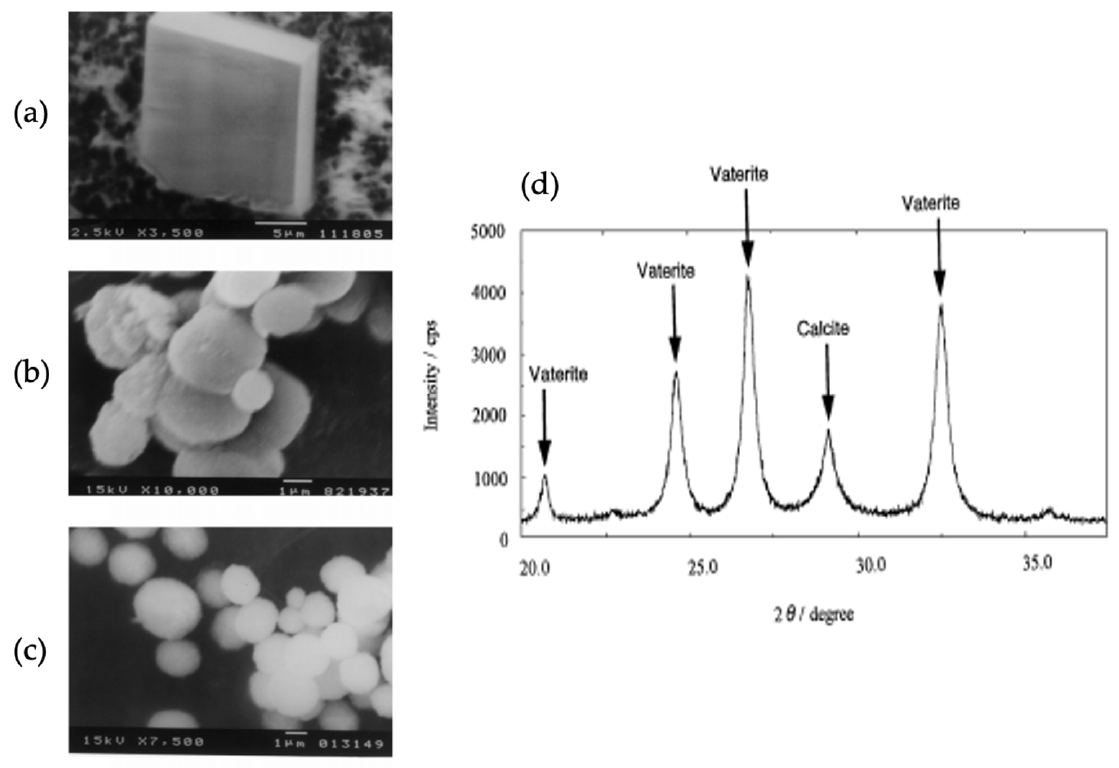
Figure 15. SEM micrographs of CaCO 3 crystals grown on a glass substrate; ( a ) in the absence of macromolecules; ( b ) in the presence of PGA; ( c ) in the presence of DNA. ( d ) X-ray diffraction pattern of CaCO 3 crystals. Soluble additive: PGA, 5.0 × 10 − 3 wt.%. Insoluble matrix: none. This Figure is adapted with permission from [64].